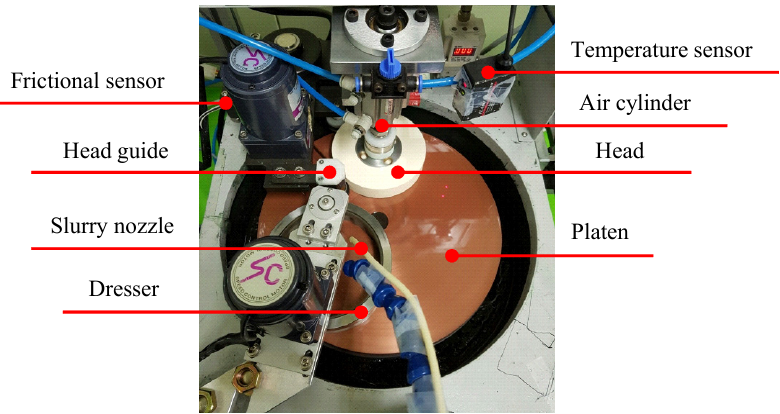
Figure 6. Lapping equipment. Figure 6. Lapping Table 1. Experimental conditions.